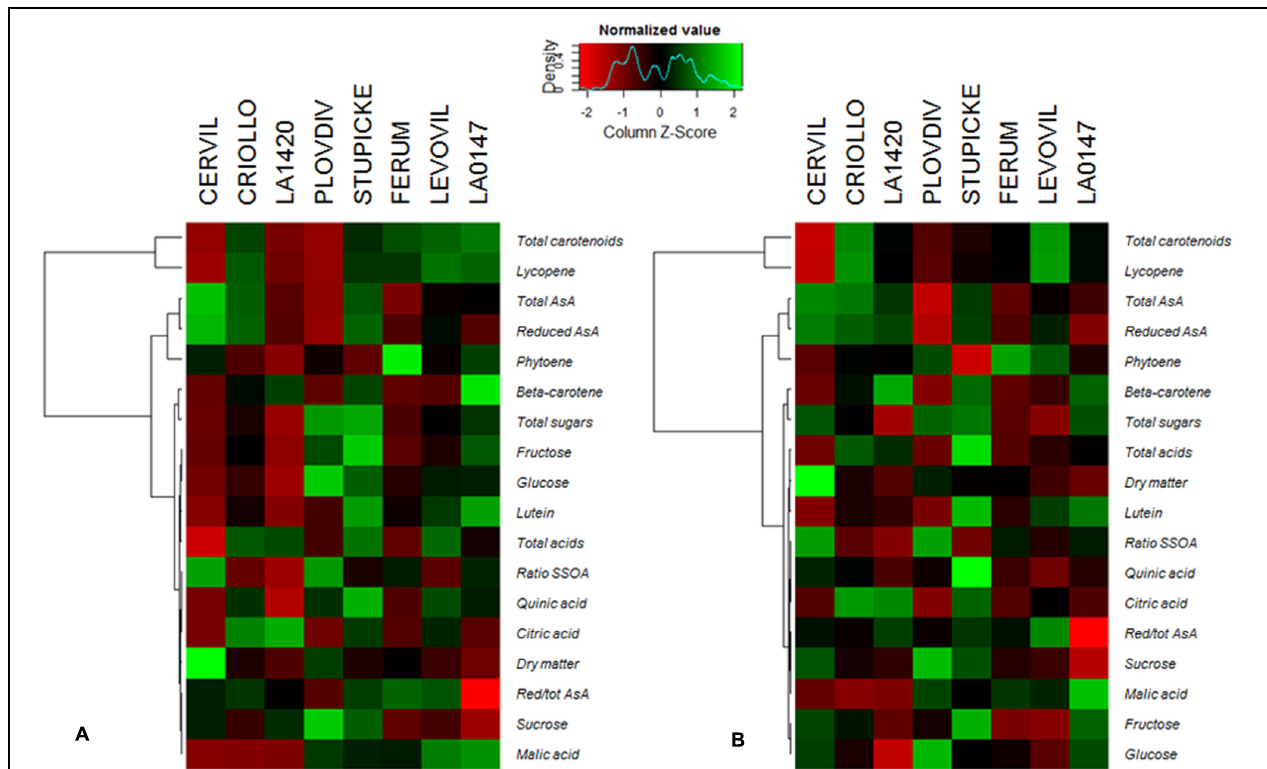
FIGURE 3 | Heat map representation of fruit composition (contents in soluble sugars, organic acids, AsA, and carotenoids expressed on a DM basis), for the parents of the MAGIC TOM population, grown under control conditions (A) and under the WD treatment (B) applied during the fruit cell division (WD1) and the cell expansion period (WD2; S1 fruits). The WD treatments consisted in three WD periods of increasing intensity followed by RPs. Data are centered and scaled by parameters ( n ≥ 5). Parameters are hierarchically classified according to Euclidean distances and ranged according to colors (green for high and red for